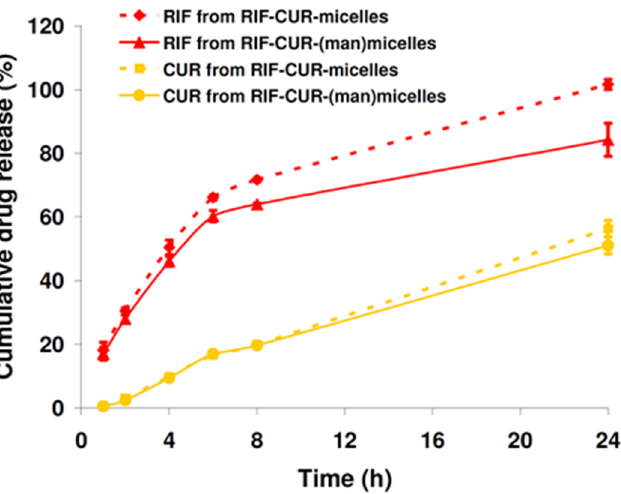
Figure 4. In vitro RIF and CUR release profiles from RIF–CUR-micelles and RIF–CUR-(man)micelles (10% w / v ) at pH 7.4 (SILF, 37 ◦ C) over 24 h. Results are expressed as mean ± standard deviation (10% w / v ) at pH 7.4 (SILF, 37 °C) over 24 h. Results are expressed as mean ± standard deviation (S.D.) (n = 3). RIF and CUR concentrations were 10 mg/mL and 5 mg/mL, (S.D.) (n = 3). RIF and CUR concentrations were 10 mg/mL and 5 mg/mL, respectively.